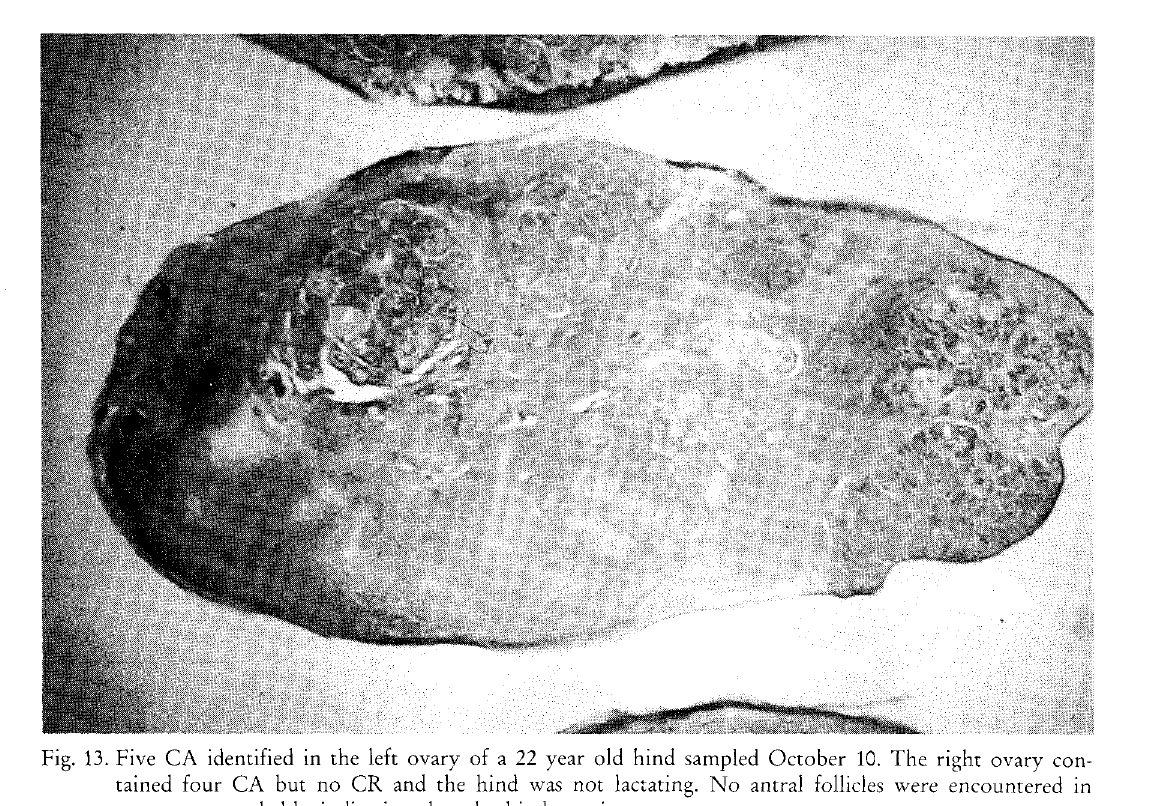
Fig. 13. Five CA identified in the left ovary of a 22 year old hind sampled October 10. The right ovary con tained four CA but no CR and the hind was not lactating. No antral follicles were encountered in any ovary, probably indicating that the hind was in